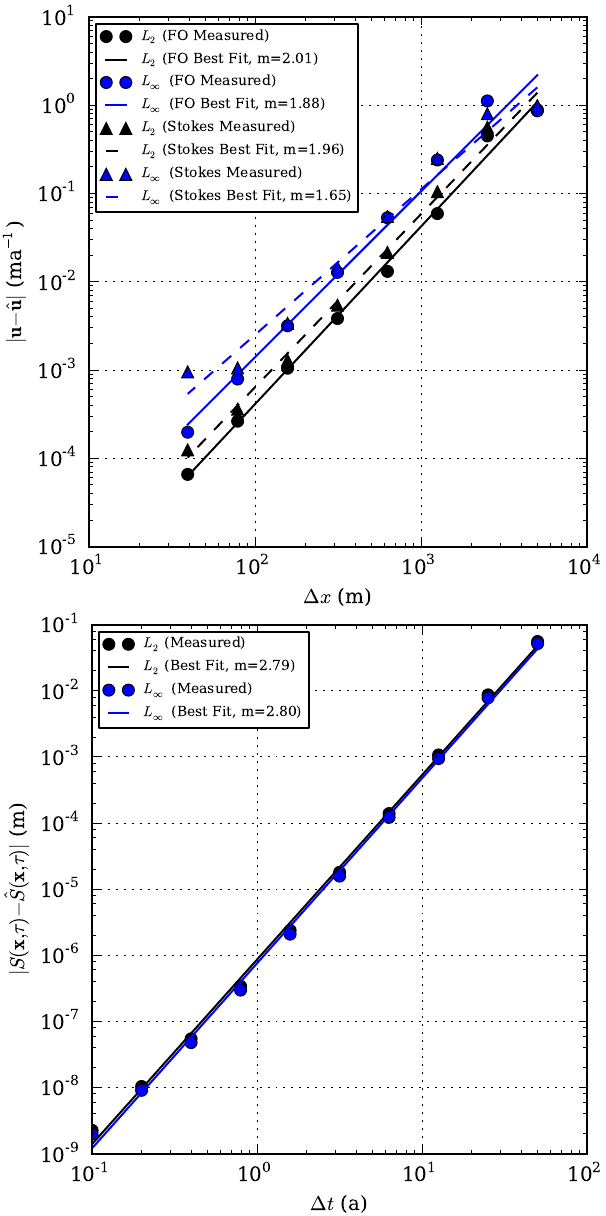
Fig. 3. Error between numerical and analytical solutions versus mesh cell size and time step. The slopes of these lines represent the convergence rates of the spatial and temporal discretization methods used by